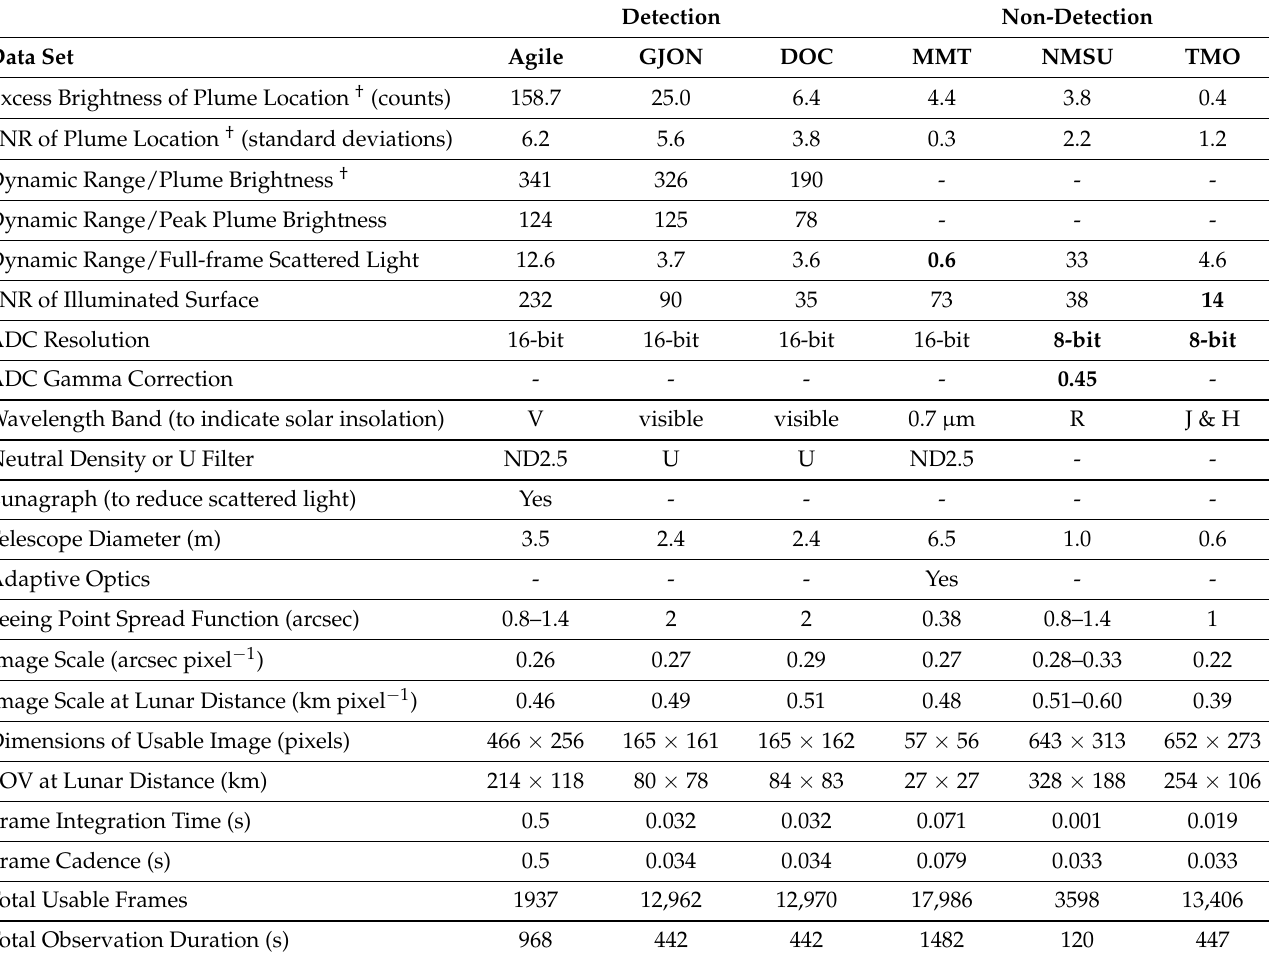
Table 4. A comparison of possible detectability factors for each data set. Values marked in bold likely account for the non-detection in that data set. † Averaged across the region indicated in Figure 4 over post-impact times from 17 to 27 s in the PCA-filtered data. The values reported for non-detections indicate the level of excess light in this region over this time span due to random fluctuations and not from a plume-like